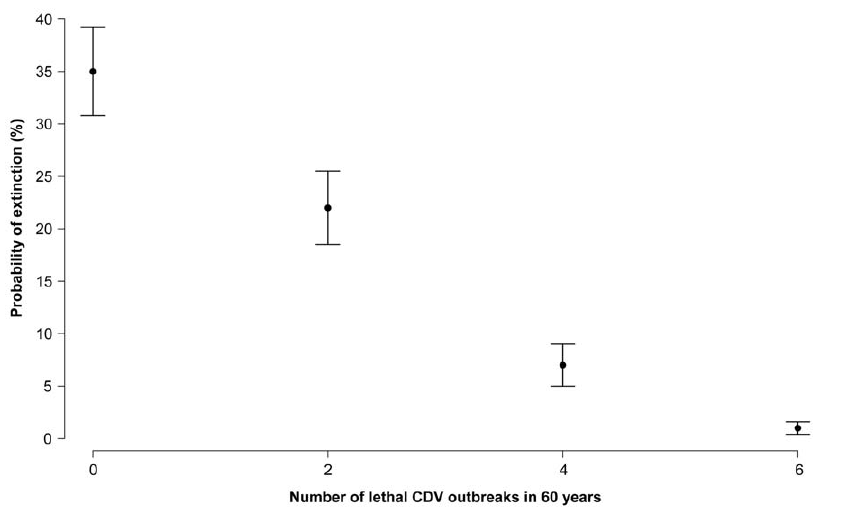
Figure 2. Probability of extinction of the Serengeti plains cheetah population for different rates of CDV outbreaks. Shown is the percentage of simulations iterations for which the population went extinct in 60 years (500 iterations were run for each outbreak rate). We assume that a rate of outbreak of 0 represents disease control through vaccination and a rate of 2 CDV outbreaks per 60 years is the rate without vaccination. Also shown is the probability of extinction of the population if the rate of CDV increases. The error bars represent the standard deviation.